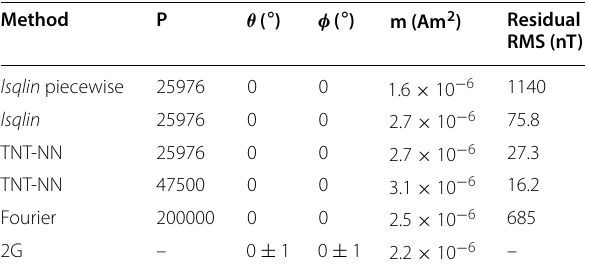
Table 2 Summary of the unidirectional basalt inversion parameters and results